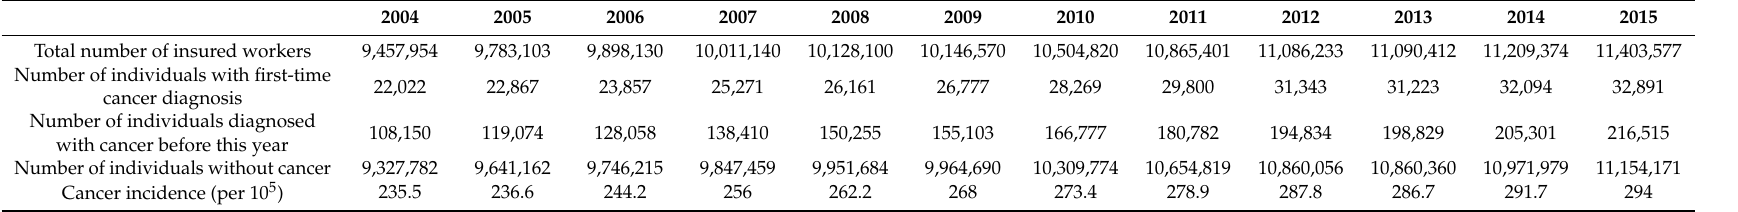
Table 1. Overall incidence of first-time cancer diagnosis among insured workers in Taiwan,